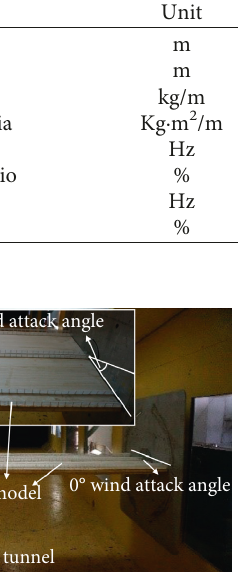
Figure 2: Test of aerostatic force coefficients.